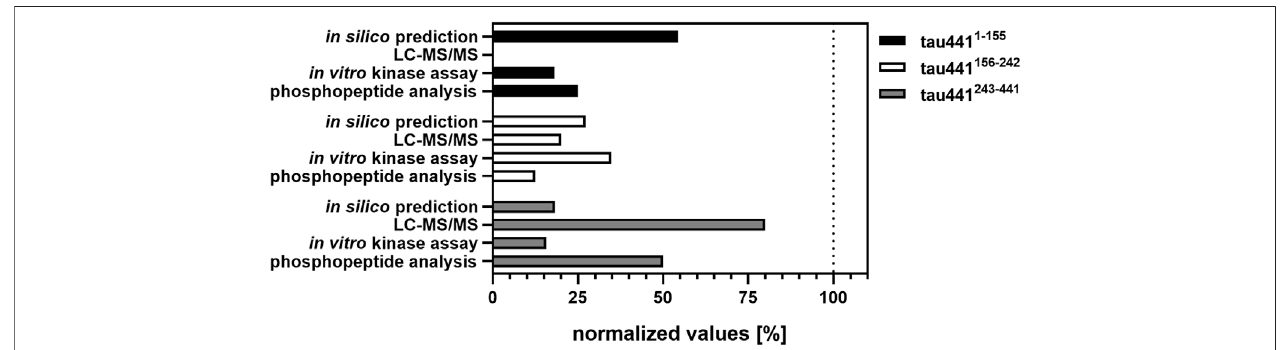
FIGURE 4 | Overview of the results obtained from in silico prediction, LC-MS/MS analysis, in vitro kinase assays and phosphopeptide analysis. Amount of the identi fi ed phosphorylation sites ( in silico prediction of CK1-speci fi c phosphorylation sites by ScanSite 4.0 at low stringency according to Krismer et al. (2021) and LC-MS/MS analysis) or phosphopeptides(visualizedbyphosphopeptideanalysis)werenormalizedtothetotalamountofphosphorylationsitesorphosphopeptidesdetectedbytherespectivemethod. Data of the in vitro kinase assays is shown as mean values of the experiments performed in triplicates and was normalized to full-length